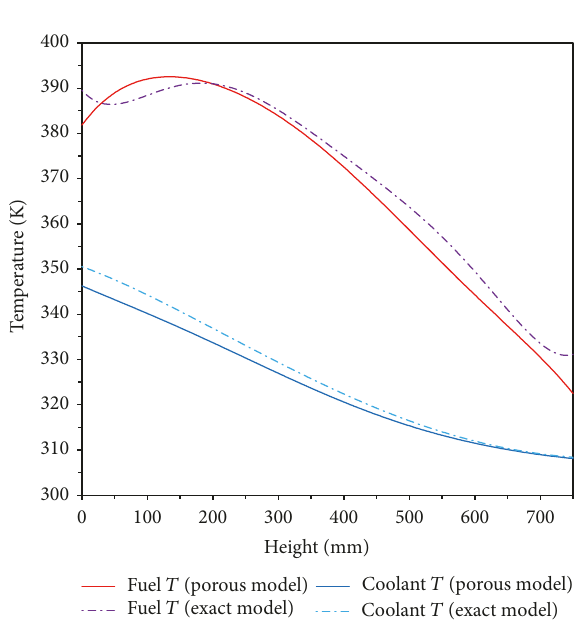
Figure 15: Calculated temperatures in number 21 follower fuel assembly.